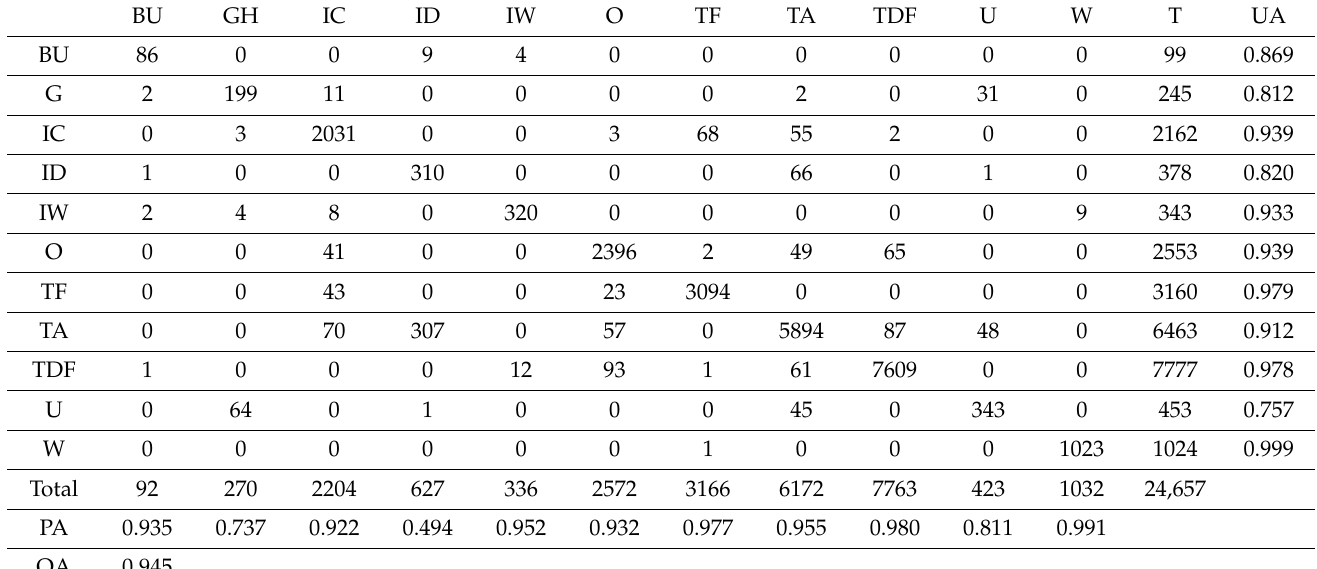
Table A3. Error matrix for accuracy assessment of the classification in 2022 using ANN.